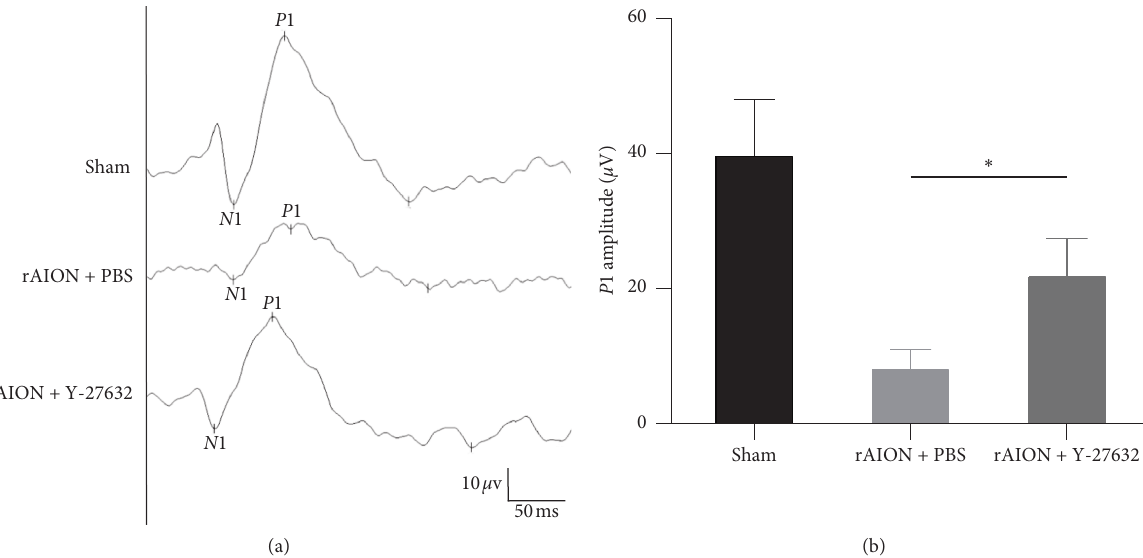
Figure 3: Evaluation of the recovery of damaged optic nerves through FVEP recording at 28 days after induction. (a) Representative FVEP wave after rAION for each group; (b) quantification of P 1 wave amplitude. The amplitude of the P 1 wave in the Y-27632-treated group was significantly higher than that in the PBS-treated group (22.2 ± 5.7 μ V vs. 8.4 ± 3.1 μ V, p < 0 . 05, n � 12 per group). The asterisk indicates p < 0 . 05, as determined by the Kruskal–Wallis test.